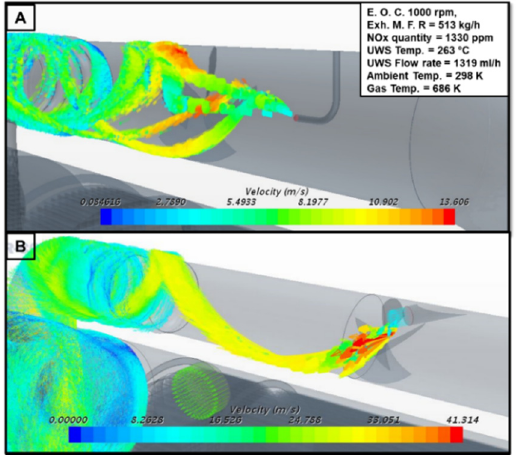
Figure 1. Urea distribution phenomena in the SCR system: ( A ) L-type urea injector and ( B ) I-type urea injector.